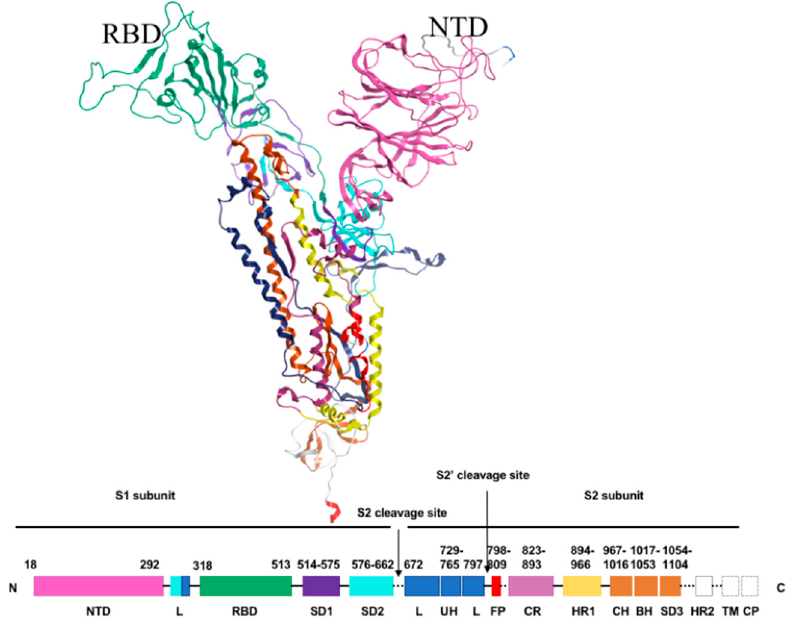
Figure 2. Schematic primary structure of the Spike Protein colored by domain. The NTD is repre- sented by the residues 18-292.